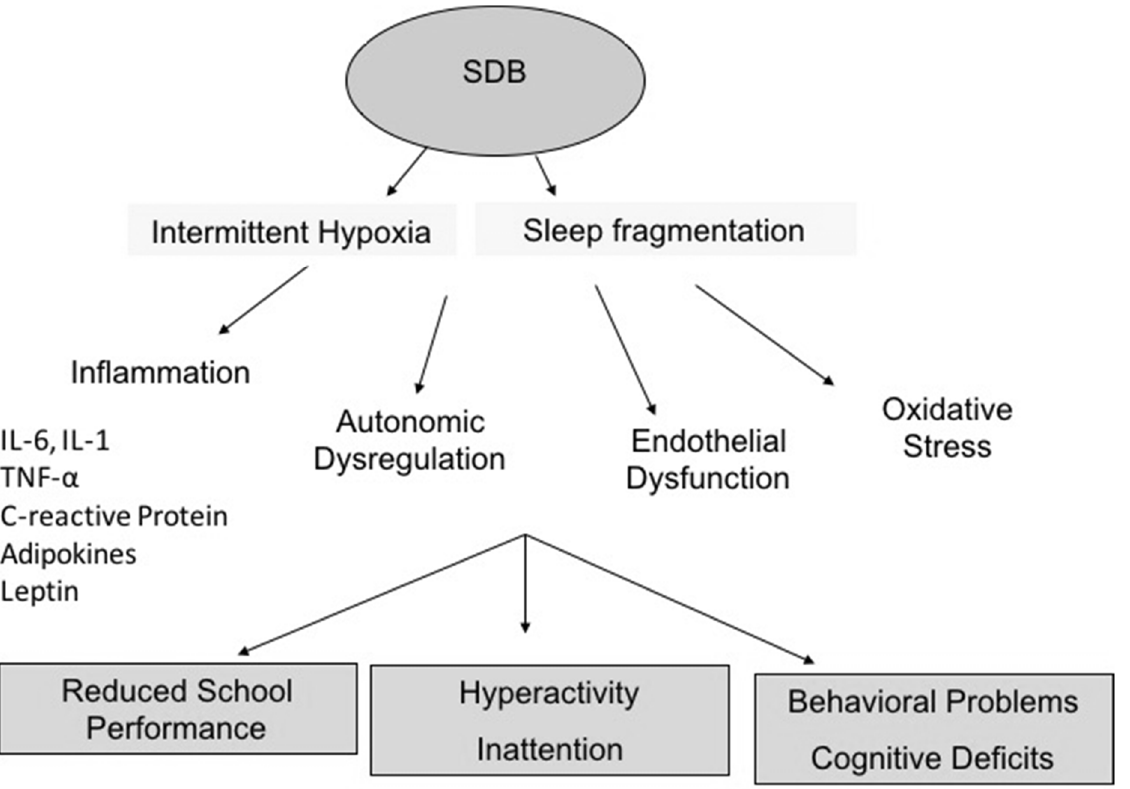
Figure 1. Summary of possible mechanisms involved in SDB ‐ related neurocognitive consequences.